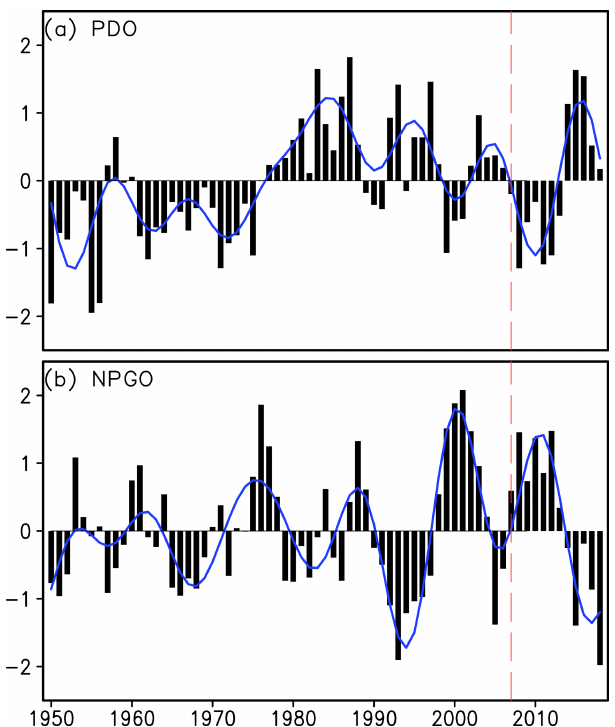
Figure 8. (a) Time series of the annual mean PDO index (black bar) superposed by its decadal component (blue line) during the period of 1950–2018. The red dashed line indicates the critical year of 2007. (b) Same as (a) , but the NPGO